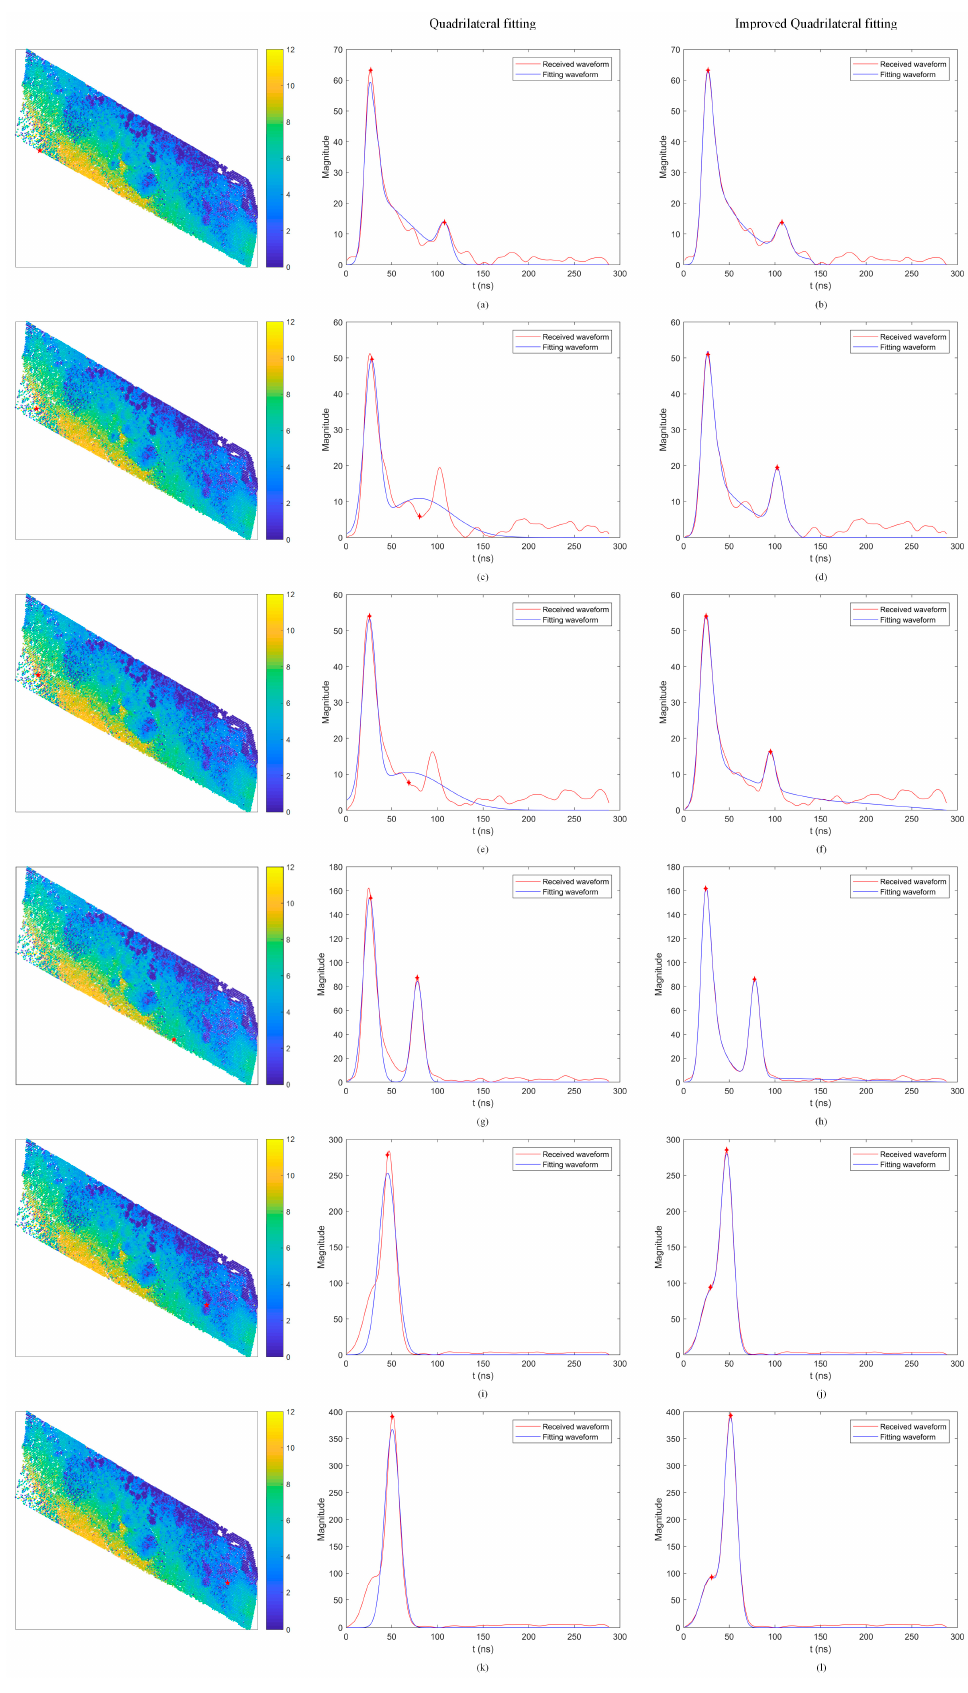
Figure 7. Six randomly selected waveforms detected solely by the QF and IQF algorithms. ( a , c , e , g , i , k ): QF algorithm; ( b , d , f , h , j , l ): IQF algorithm.